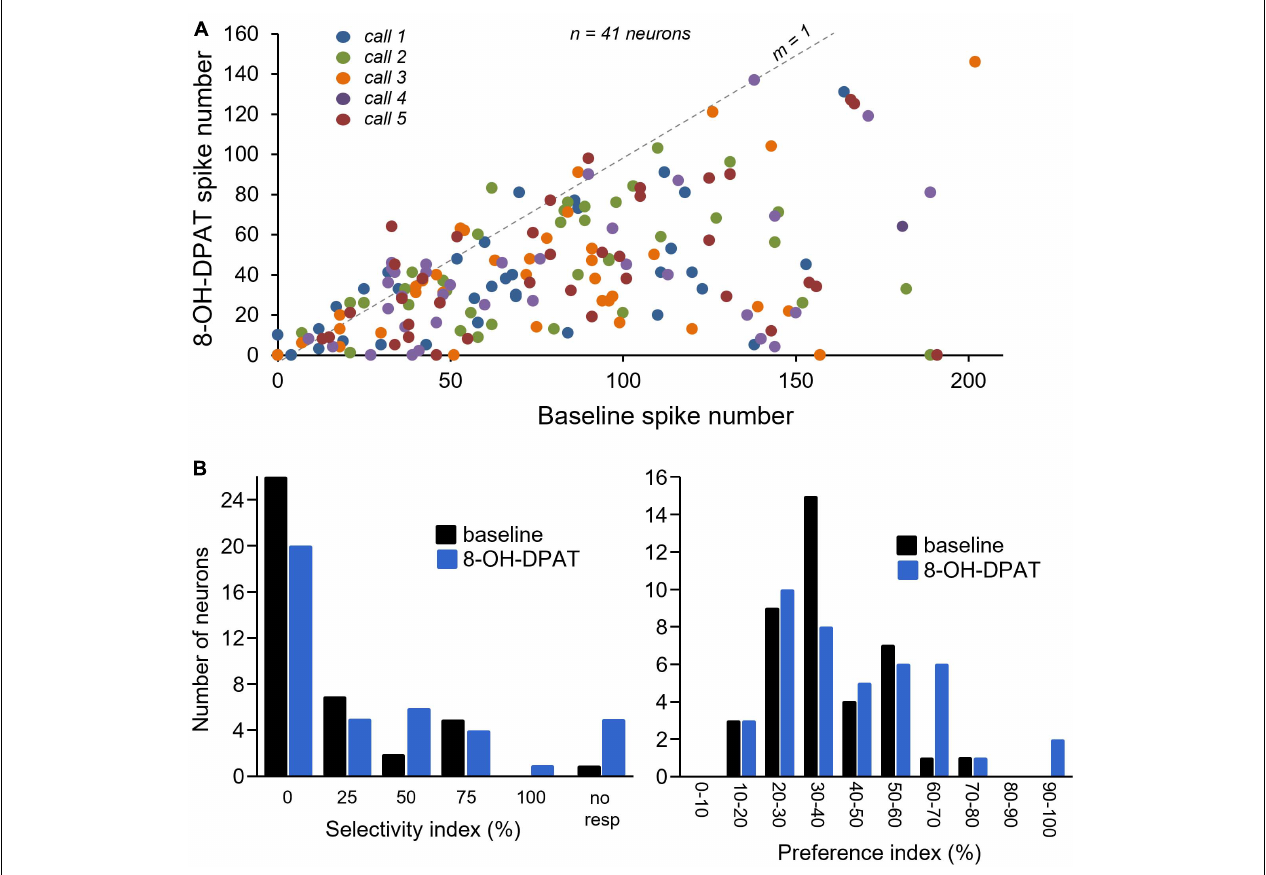
FIGURE 7 | (A) Comparison of numbers of spikes in response to specific calls in the baseline (no drug application) versus during 8-OH-DPAT application. Symbols below the line with a slope of 1 represent a suppression of spikes during drug application. Different colors represent responses to different calls. (B) Selectivity index and preference index in a subset of 41 neurons in baseline and during exposure to